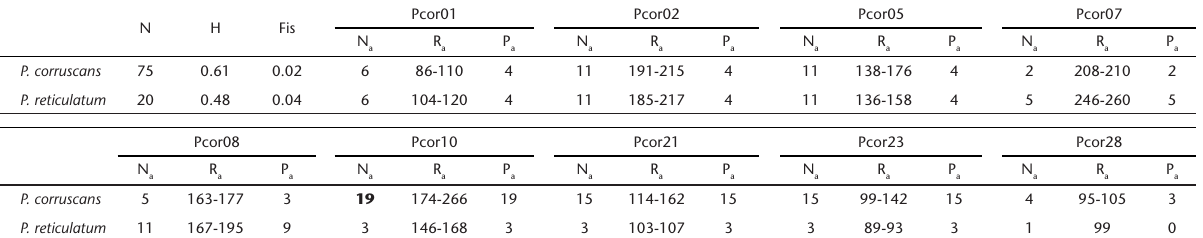
Table 2. Number of adults of P. corruscans and P. reticulatum sampled (N), gene diversity (H), inbreeding coefficient (Fis), number of alleles (N ), range of alleles (R ) and number of private alleles (P ) for each of nine microsatellites loci. Bold number of Fis represent significant a a a values and bold number of N represent deviation of Hardy-Weinberg equilibrium. a N H